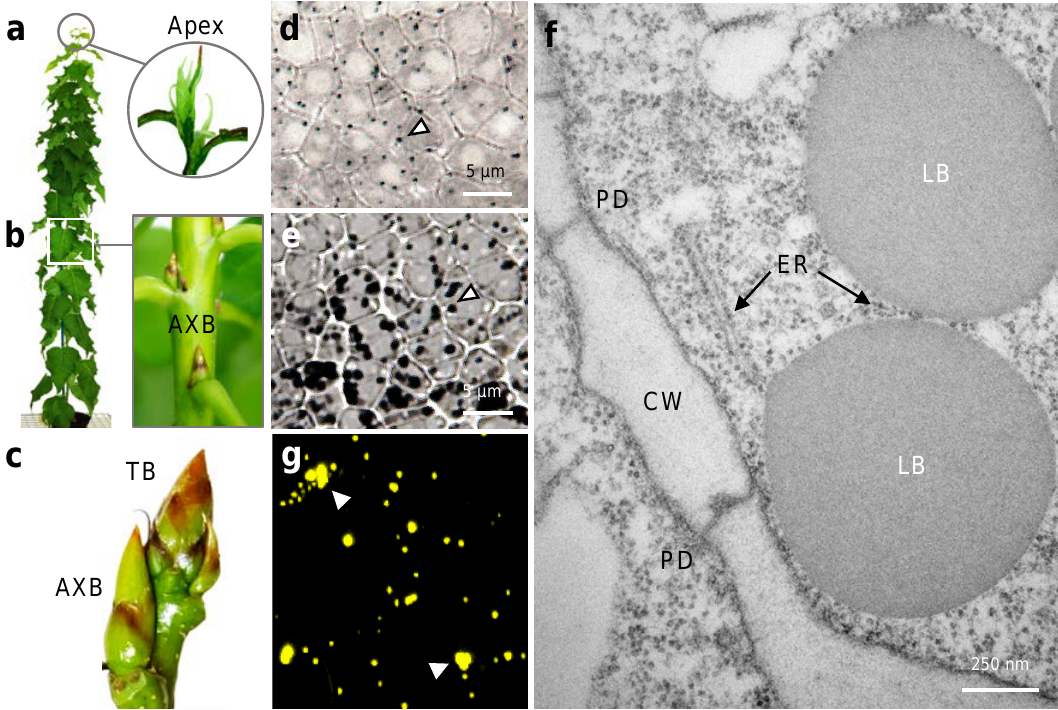
Figure 1. Lipid bodies (LB) are common constituents of shoot meristem cells in hybrid aspen. Under a long photoperiod ( a , b , d–f ), the actively growing shoot apex ( a ) (circled) harbors the shoot apical meristem, which possesses a few LBs ( d ) that are visible as dark blue spots after staining with the lipid stain Sudan Black (white arrowhead). ( b ) Quiescent axillary buds (AXB) (boxed) host numerous, relatively large LBs, which stain intensely black ( e ) (white arrowhead). In TEM micrographs, LBs could be seen ( f ) in the proximity of the plasma membrane and plasmodesmata (PD). Under a short photoperiod ( c,g ) the apex forms a terminal bud (TB), whereas young AXBs enlarge ( c ) and accumulate LBs. Isolated LBs from dormant buds ( g ) retained their spherical shape, although some coalescence was observed (white arrowheads), stained with the neutral lipid stain Nile Red. Endoplasmic reticulum (ER); cell wall